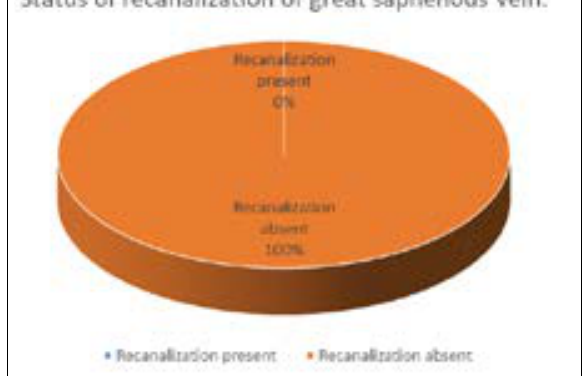
Figure 2. Recanalization of the ablated vein.